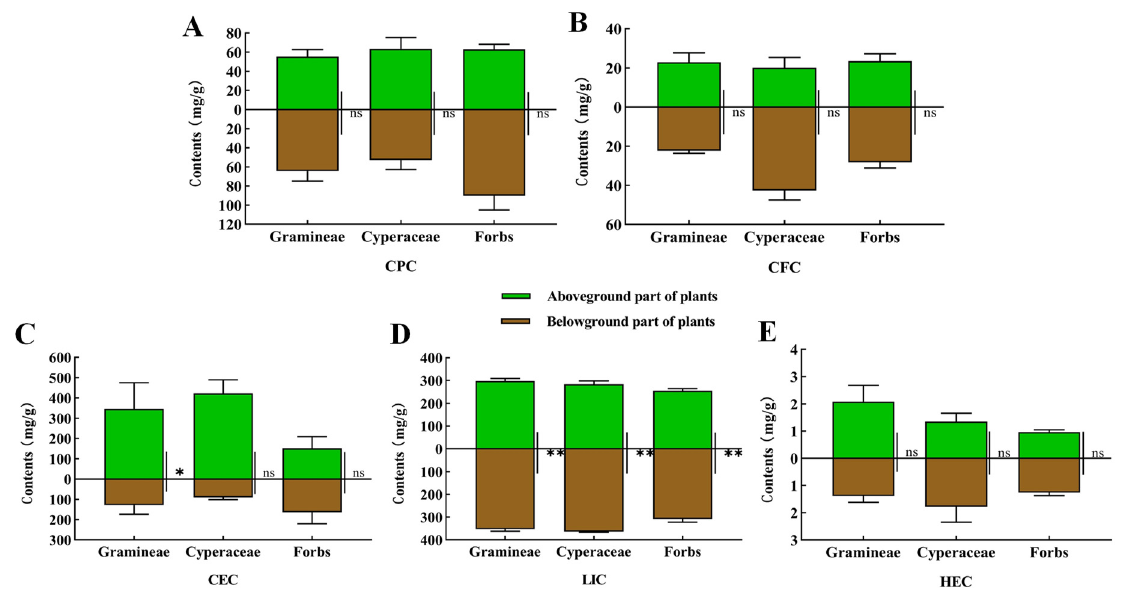
Figure 2. Plant nutrients in the habitats of the plateau zokor and plateau pika. ( A ) The CPC of plant nutrients; ( B ) The CFC of plant nutrients; ( C ) The CEC of plant nutrients; ( D ) The LIC of plant nutrients; ( E ) The HEC of plant nutrients. * indicates significant difference ( p < 0.05); ** indicates an extremely significant difference ( p < 0.01); ns indicates an insignificant difference.